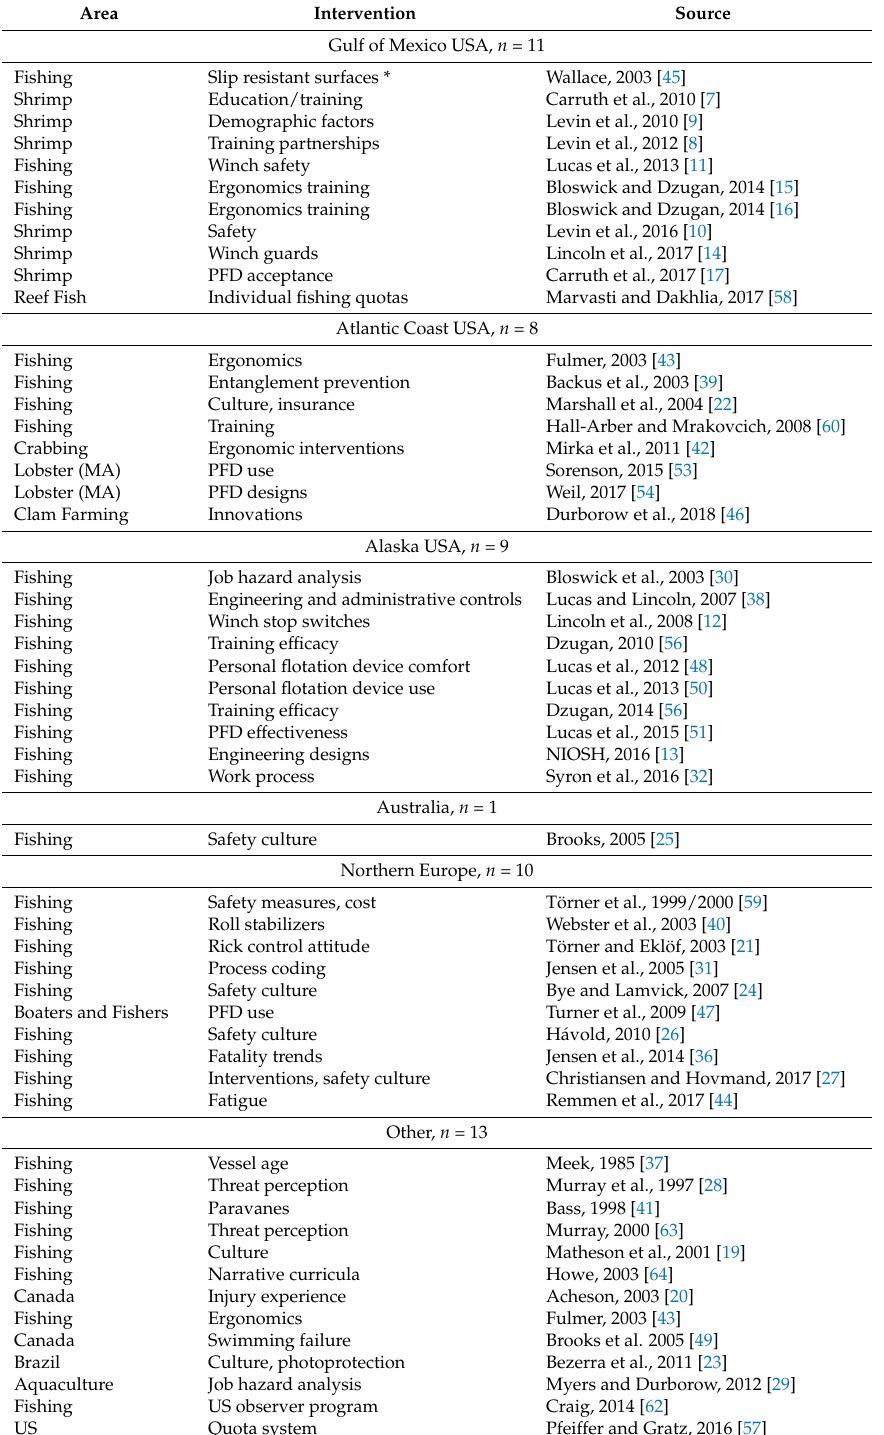
Table A1. The geographic origin (area) of the study, the intervention and a reference to the literature source, n =